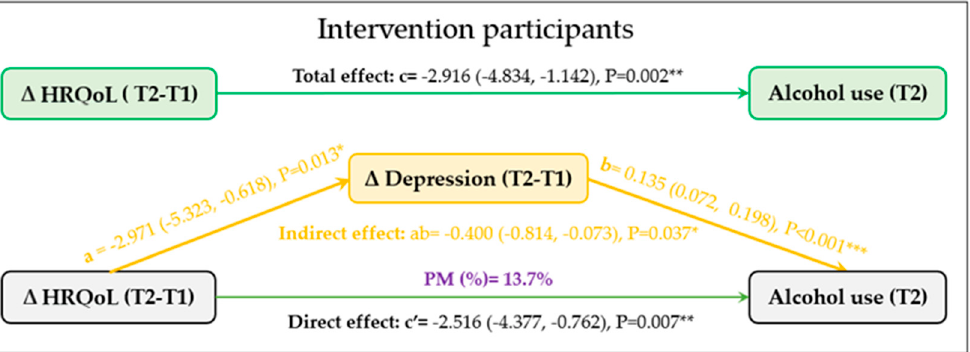
Figure 2. The mediation role of change in depressive symptoms ( ∆ T2-T1) on the relationship between change in health- related quality of life (HRQoL) ( ∆ T2-T1) and alcohol use (T2) among intervention participants (n = 519). * p < 0.05, ** p < 0.01, *** p < 0.001.